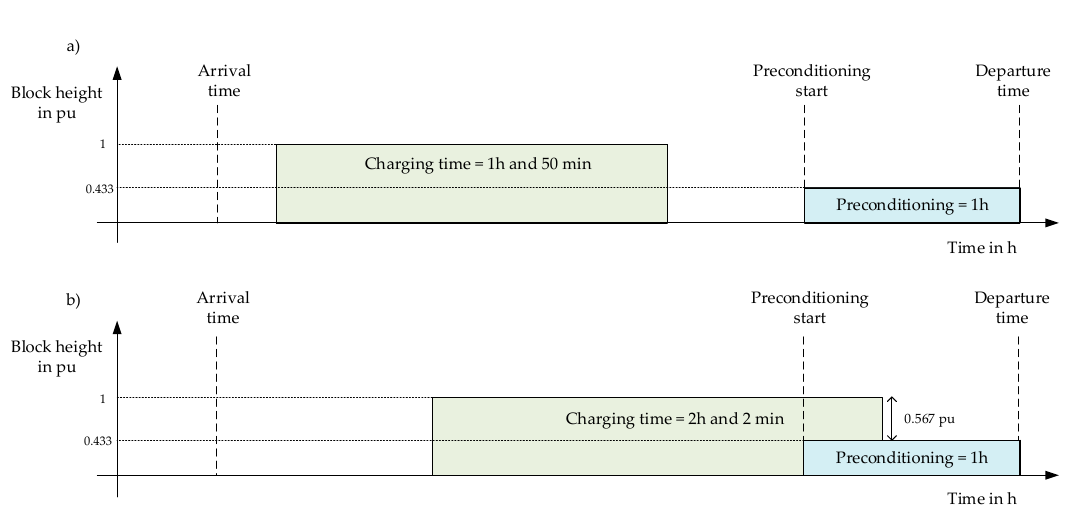
Figure 5. Change in the length of the charging block (green) due to the preconditioning block (blue) for two different scenarios: ( a ) no overlapping with preconditioning; charging time is 1 h and 50 min and ( b ) overlapping with preconditioning for 15 min; charging time is 2 h and 2 min.